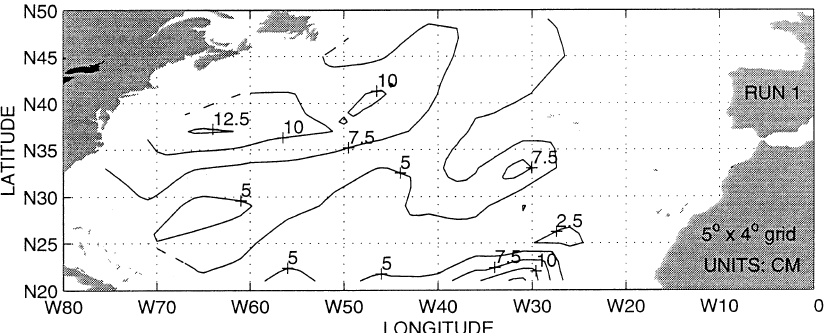
Fig. 6. Uncertainty (cm) in the 5 (cid:176) (cid:180) 4 (cid:176) mean dynamic topography estimated by the inverse model combining hydrographic and altimetric observations (run 1)